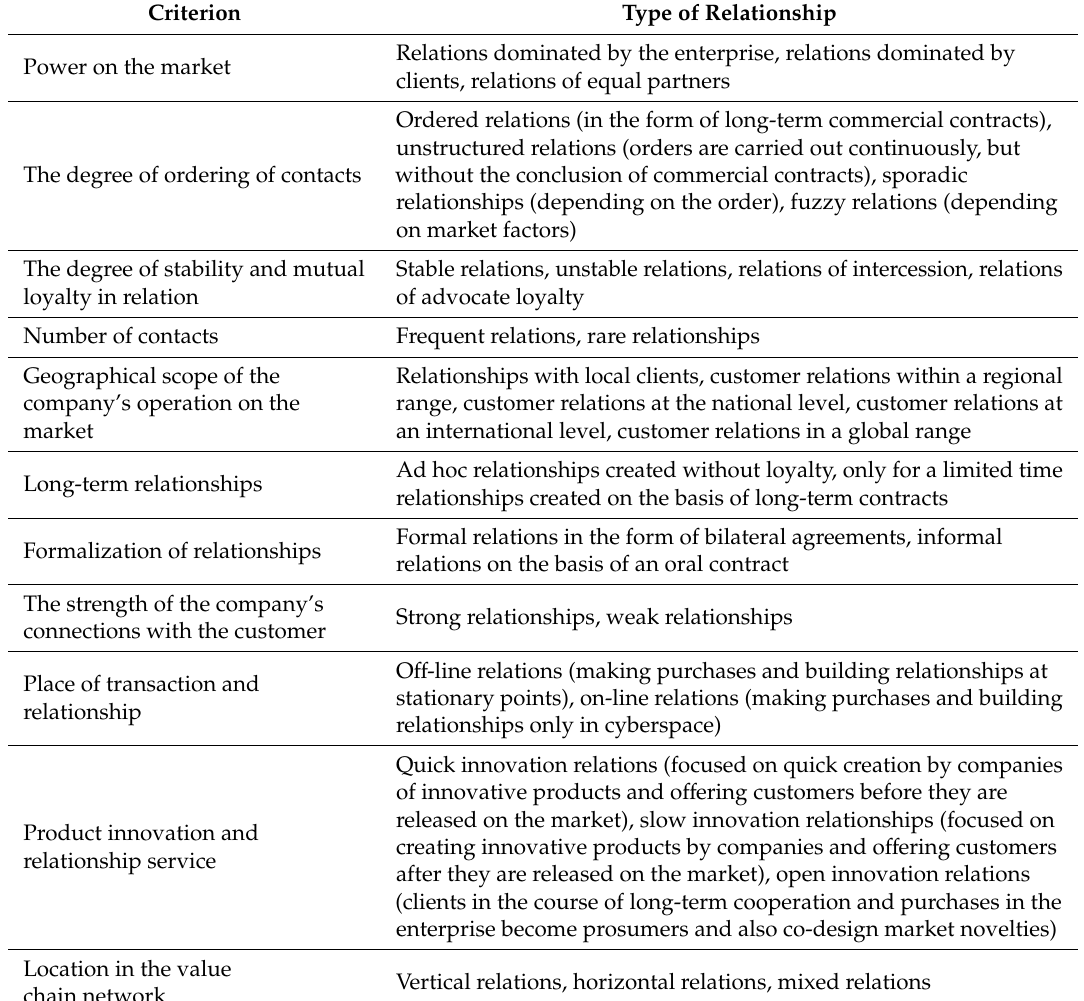
Table 3. Classification of business relationships with clients due to selected